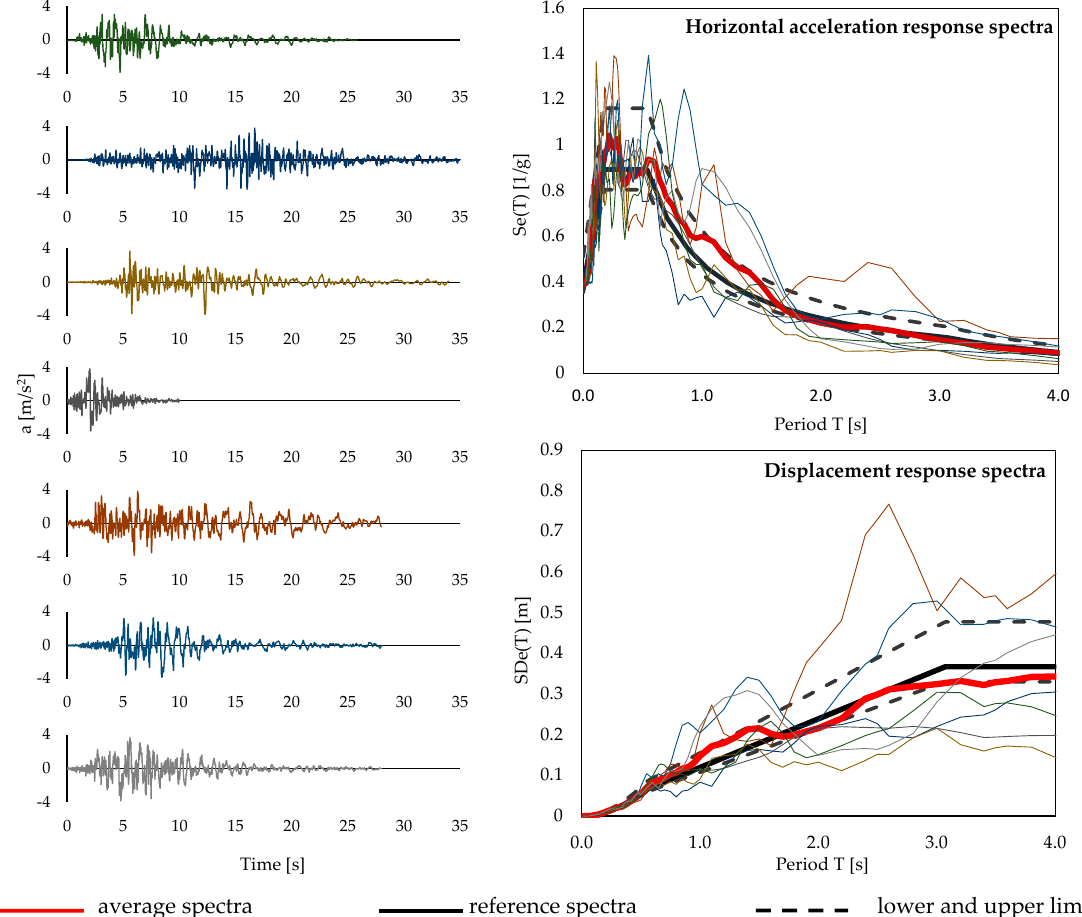
Figure 4. Ground motion records and horizontal elastic displacement (S De ) and acceleration (S e ) response spectra.